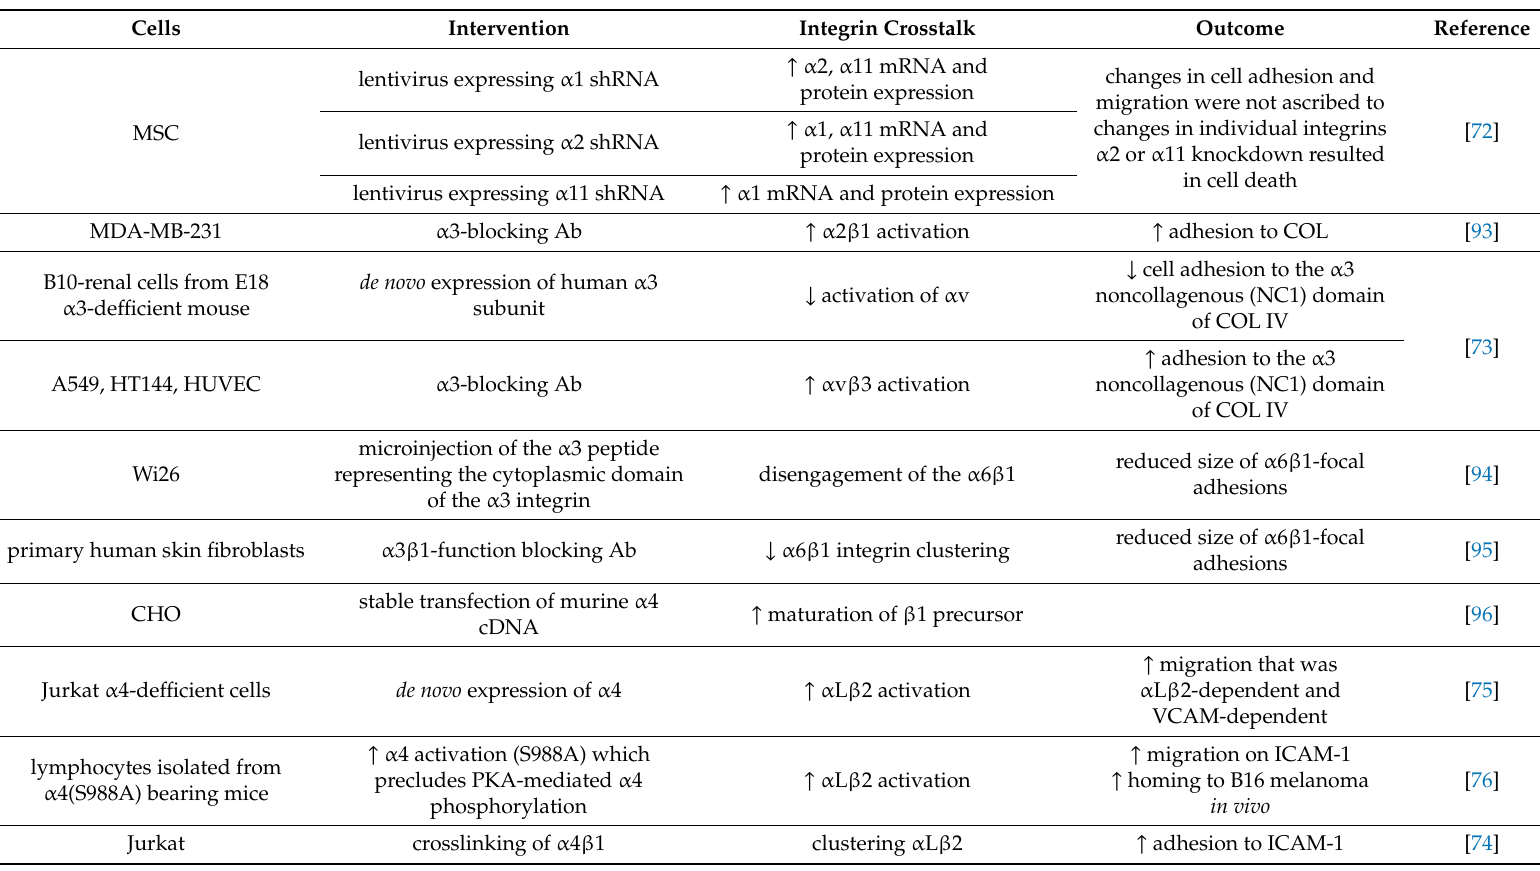
Table 1. Integrin crosstalk examples found in di ff erent research models. The table describes only integrin crosstalk events and corresponding